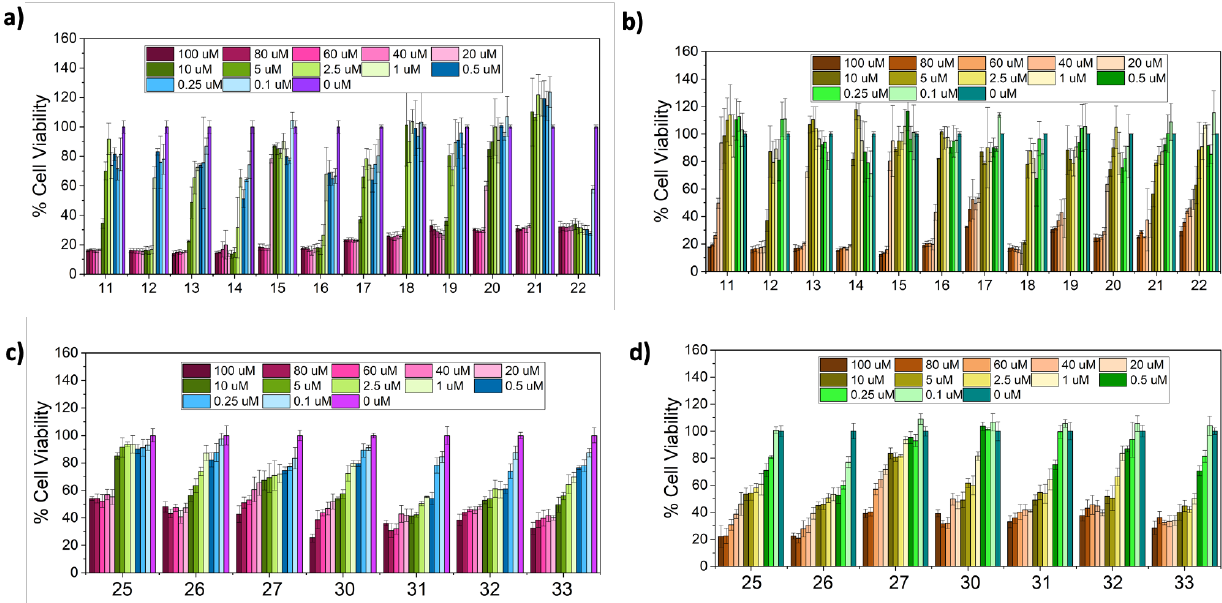
Figure 6. ( a ) Cell viability of Series 1 (compounds 11 – 22 ) in Balb and ( b ) HeLa cells. ( c ) Cell viability of Series 2 and 3 (compounds 25 – 33 ) in Balb and ( d ) HeLa cells.